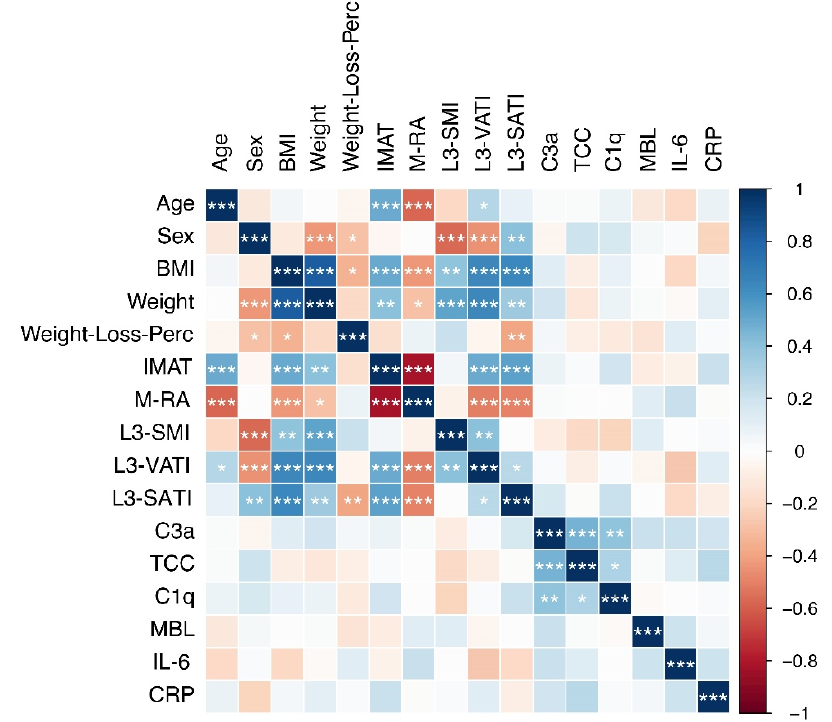
Figure 3. Correlation plot showing Spearman correlations between indicated cachexia-related vari- ables and complement factors. Positive correlations are shown in blue, negative correlations in red. The color intensity indicates the strength of the correlation. The asterisks indicate the level of statistical significance (* p ≤ 0.05, ** p ≤ 0.01, *** p ≤ 0.001).